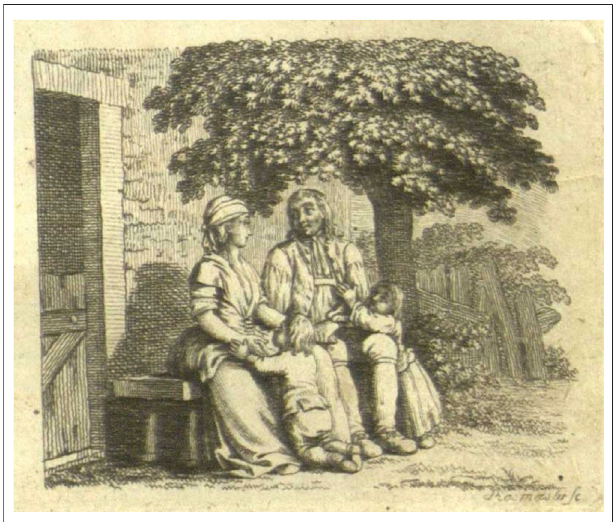
FIGURE 9 | Title-page illustration, Claudius (1783). Universitätsbibliothek Augsburg, shelfmark 221/GK 9951 C615